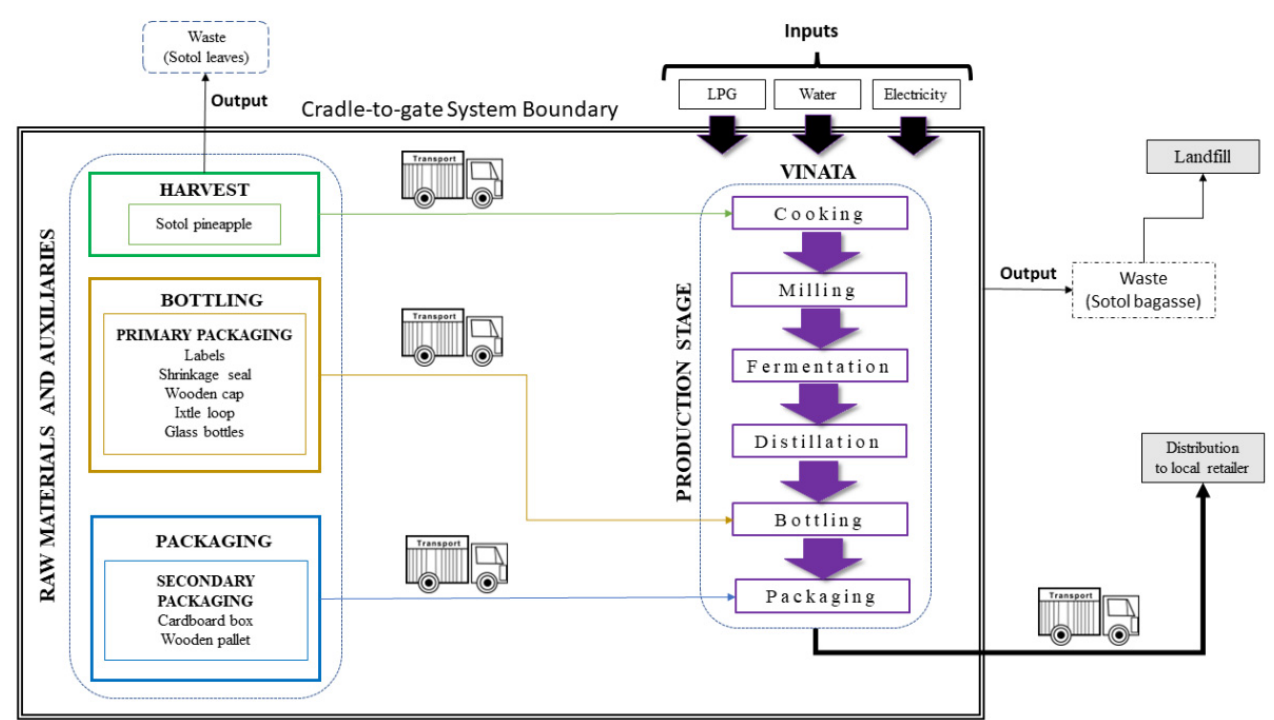
Figure 1. System boundary of sotol production.